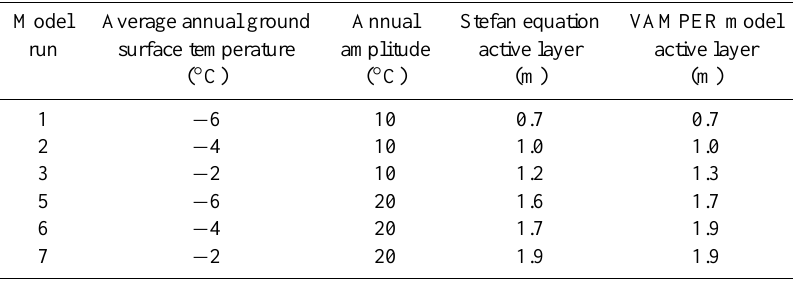
Table 2. Calculated maximum annual active layer thickness using both the Stefan equation and the VAMPER model under different forcing